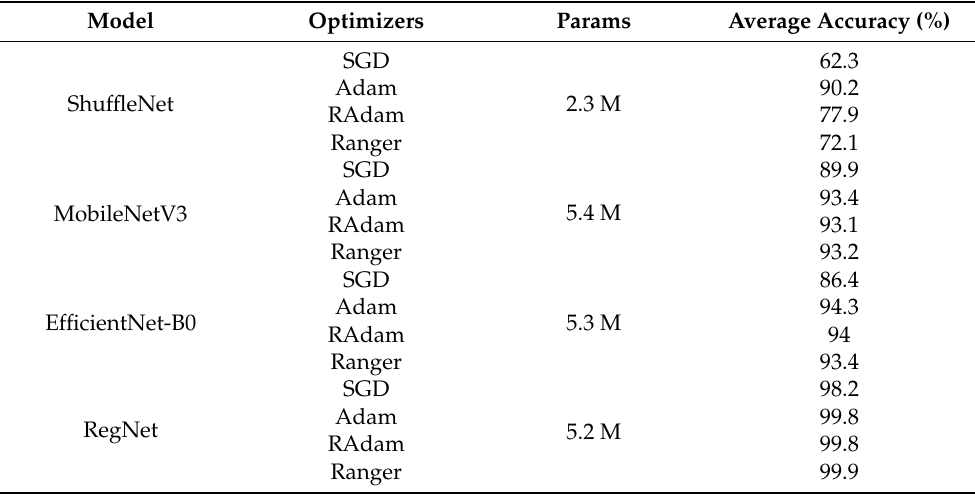
Table 2. Performance comparison of different optimizers for four network